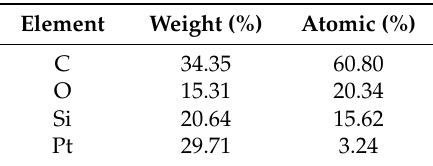
Figure 4. Carbon has the highest peak among all compositions in the Gr-MRE during EDX observations. Table 2. Elements in the Gr-MRE.